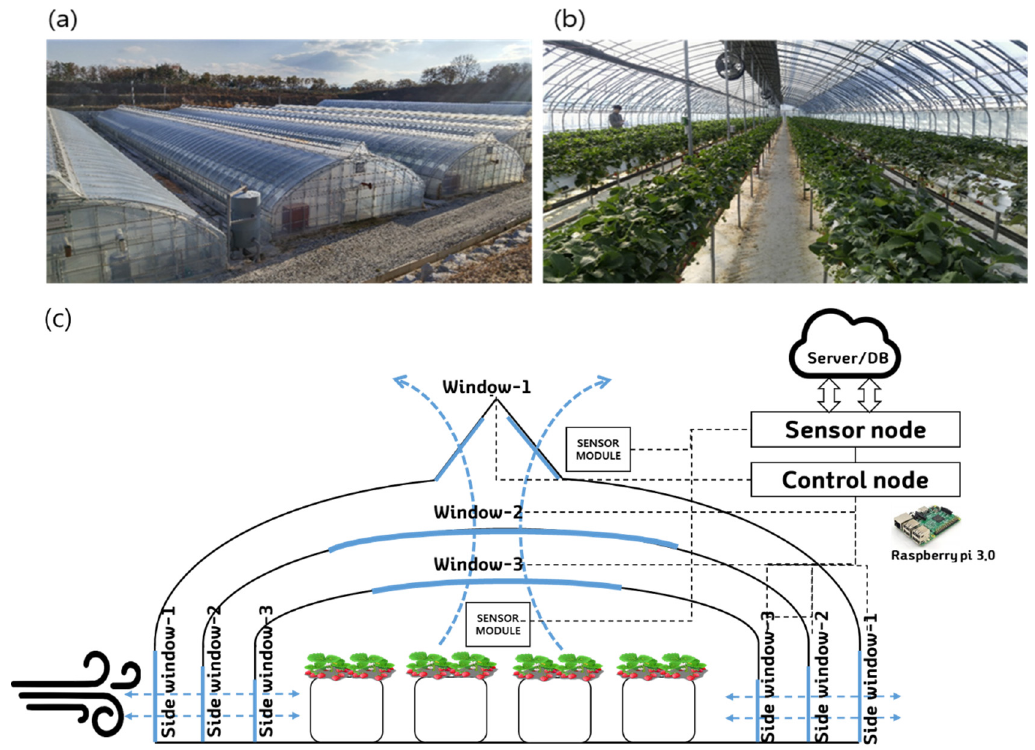
Figure 1. Strawberry greenhouse used in this study: ( a ) exterior and ( b ) inside with multi-window shell structure, and ( c ) schematic of experimental greenhouse monitoring and control system.